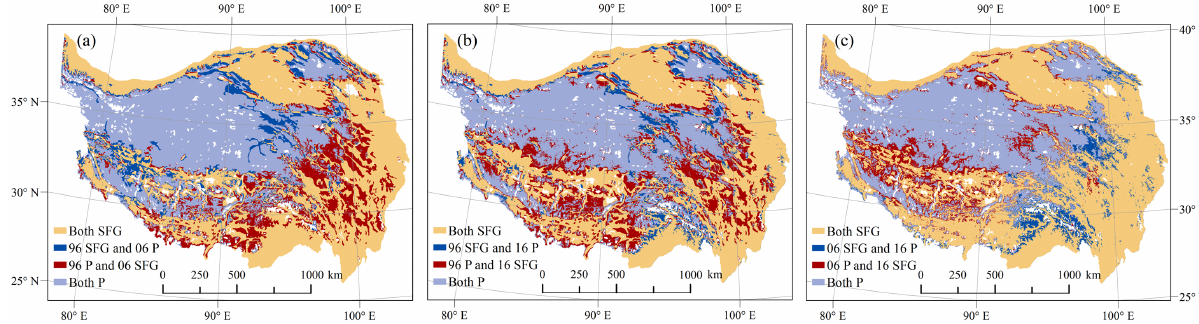
Figure 7. Spatial difference among the three maps (96: TP-1996, 06: TP-2006, 16: TP-2016; SFG: seasonally frozen ground, P: permafrost).